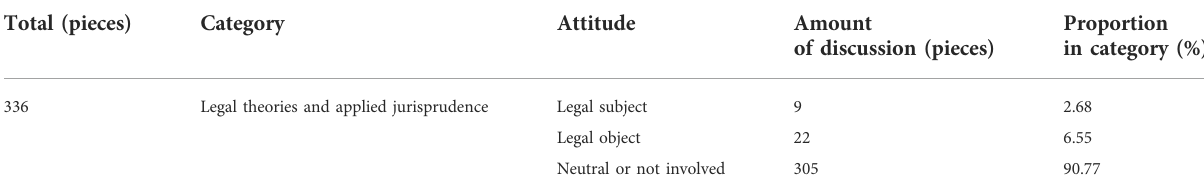
TABLE 1 Academic debates on the topic of the legal status surrounding embryo research in China. Total